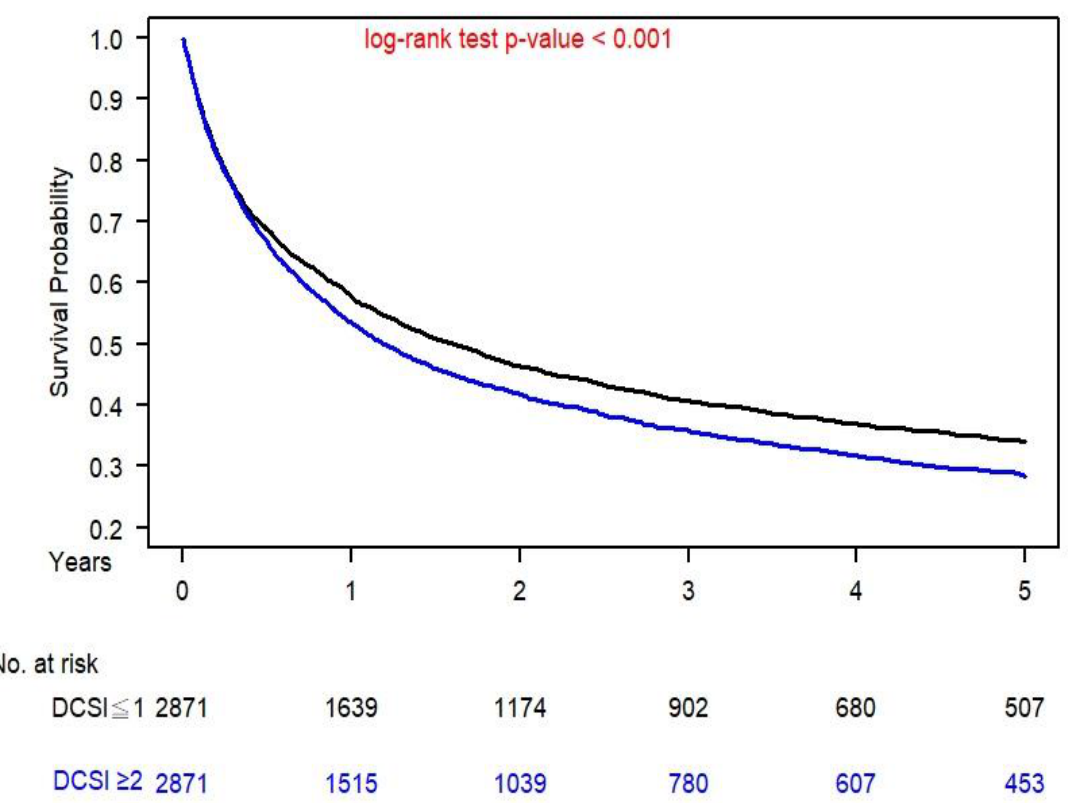
Figure 2. Kaplan – Meier overall survival curves for patients with both lung squamous cell carcinoma and mild or moderate-to-severe diabetes. and mild or moderate-to-severe